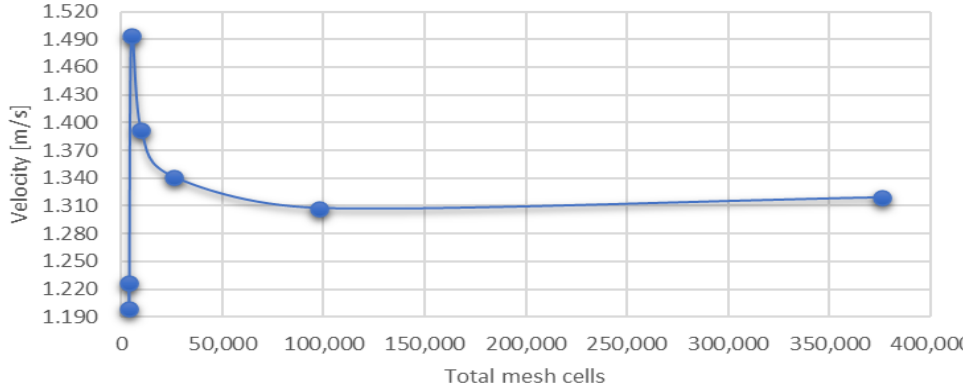
Figure 6. Velocity versus length for different mesh refinements for the geometry with upper air inlet and outlet.